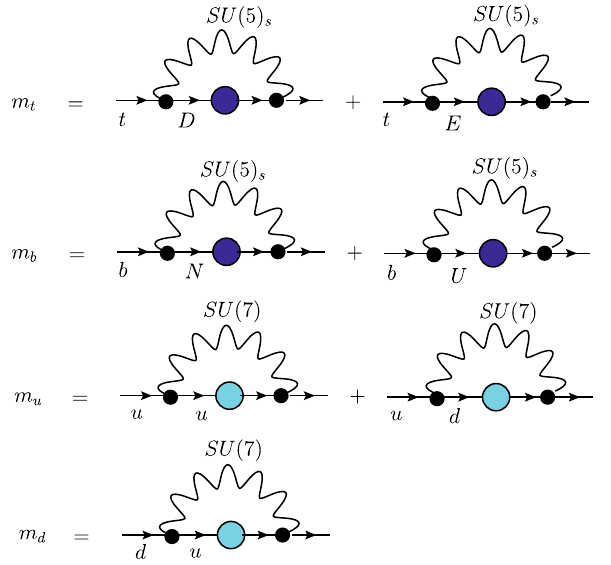
Fig. 3 Quark masses in the coupled TC scheme of Eq. (10), for the fermionic content given by Eqs.(16) and (17)